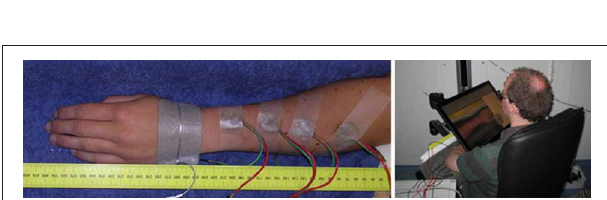
not touch the needle electrodes. The left and middle panels show the compound electrode without and with this pad. A schematic diagram of the compound electrodes is presented in the right panel.